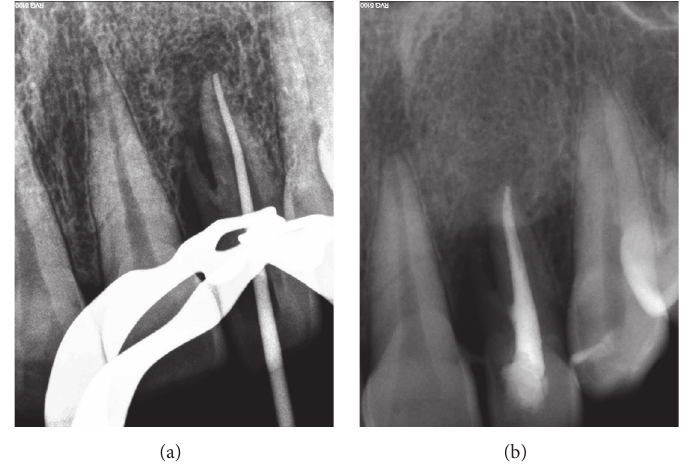
Figure 3: Toot #10 was endodontically